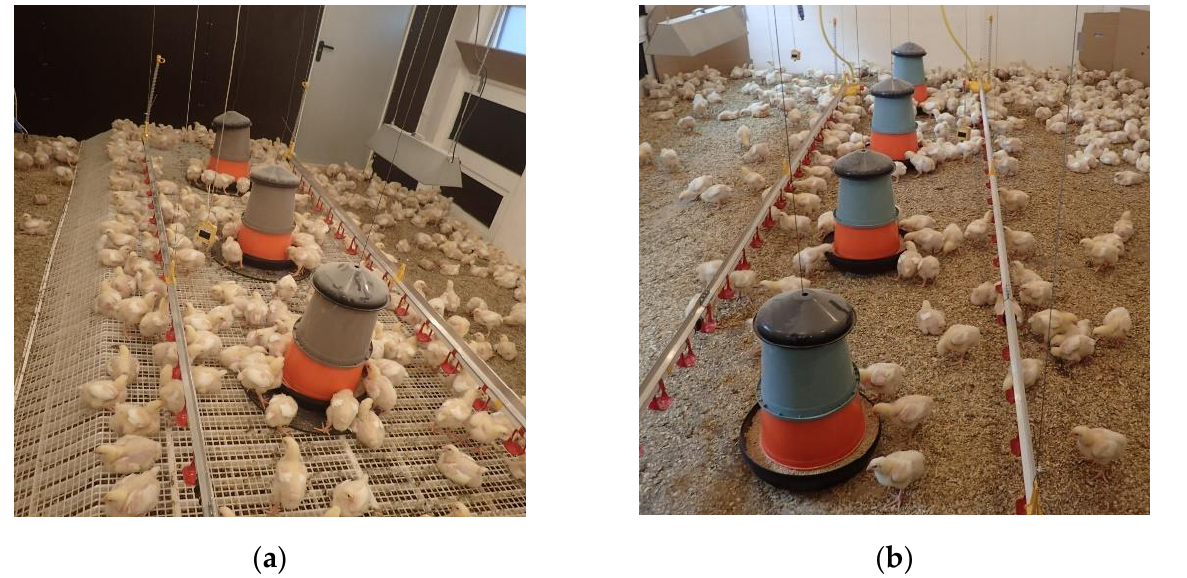
Figure 1. ( a ) Experimental barn with elevated perforated floor and littered areas. ( b ) Control barn with the littered floor. with the littered